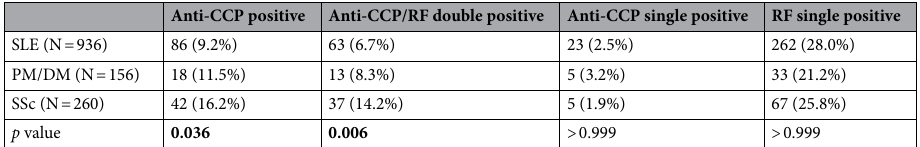
Table 1. Anti-CCP antibody and RF positivity in connective tissue diseases. Values are expressed as n (%). All p values Bonferroni corrected. SLE, systemic lupus erythematous; PM, polymyositis; DM, dermatomyositis: SSc, systemic sclerosis. Significant values are in [bold].